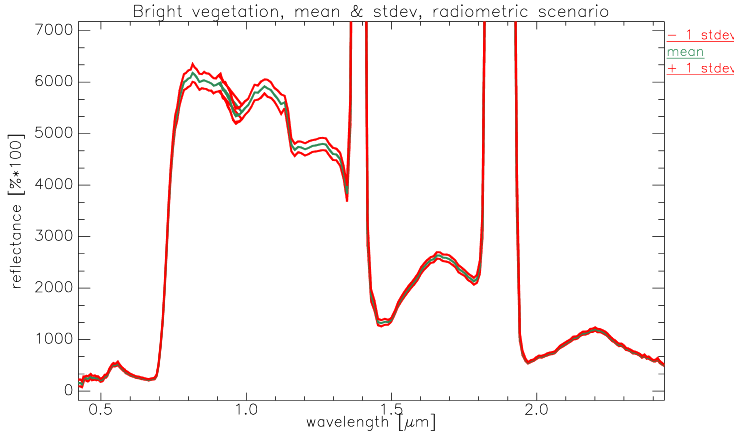
Figure 5. Plot of the mean spectrum and the standard deviation (stdev) calculated over all realisations for the ROI “bright vegetation”.